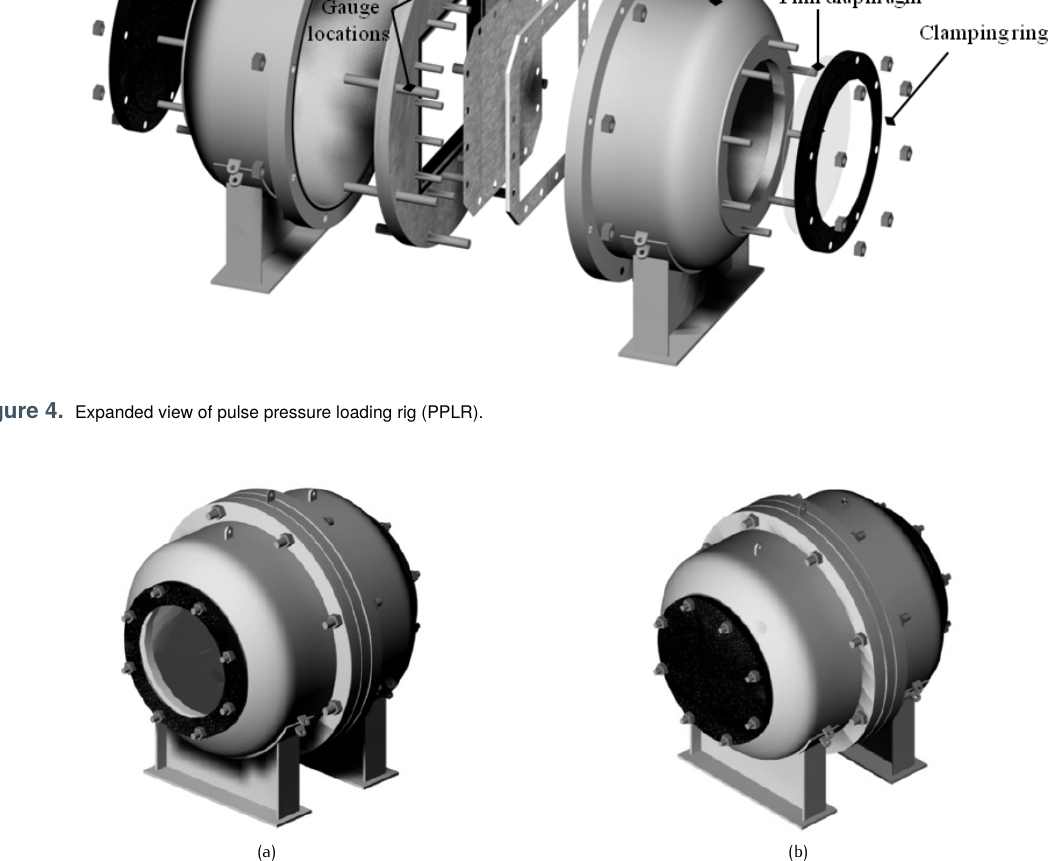
Figure 5. PPLR assembled (a) with film diaphragm and clamping ring (dynamic mode) and (b) with end cover plates (static